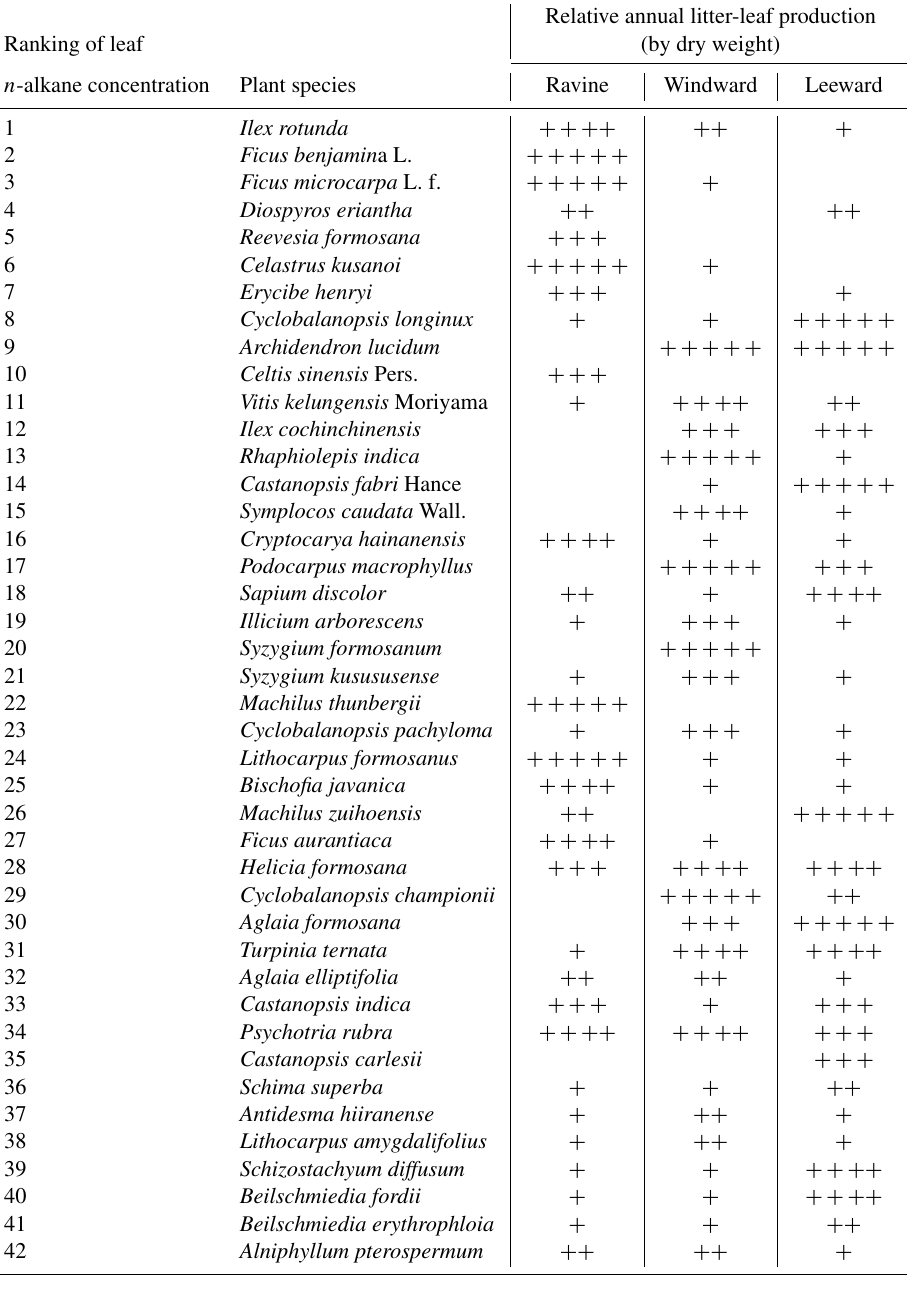
Table 1. The resultant ranking of n -alkane concentration of 42 litter-leaf samples with the nomenclature and the semi-quantitative results of annual litter-leaf productivity in three habitats. The plus sign ( + ) was used to denote the annual productivity rankings of litter-leaf in each habitat. Five plus signs ( +++++ ) denote the litter-leaf productivity rankings from 1 to 5; four plus signs ( ++++ ) denote the productivity rankings from 6 to 10; three plus signs ( +++ ) denote the rankings from 11 to 15; two plus signs ( ++ ) denote the rankings from 16 to 20; one plus sign ( + ) denotes the rankings after 21. A blank space denotes no litter-leaf yield for the entire year in the